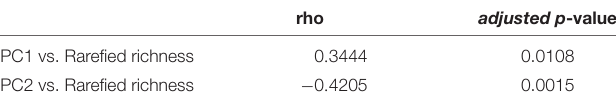
TABLE 4 | The correlation statistics between plant species richness and the first two axes of a joint principal component analysis. rho